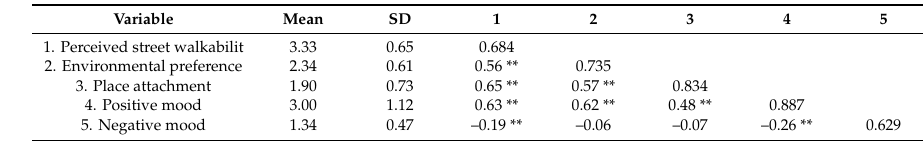
Table 3. Descriptive statistics, correlations, and discriminant validity among the